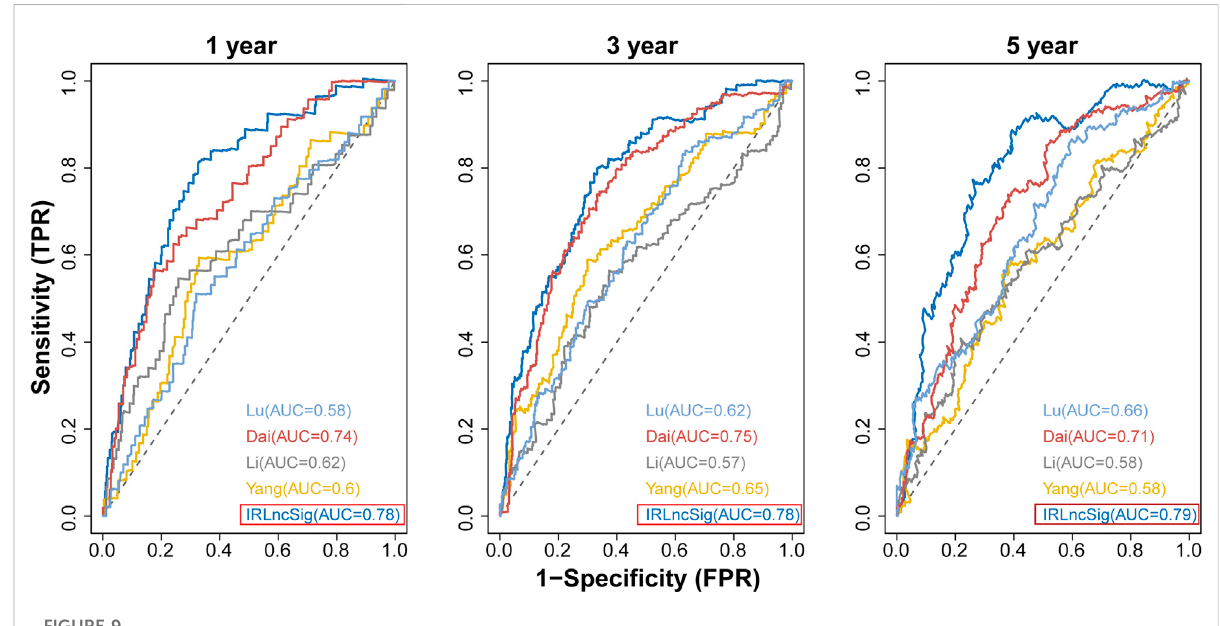
FIGURE 9 Comparison of IRLinSig with other existing prognostic